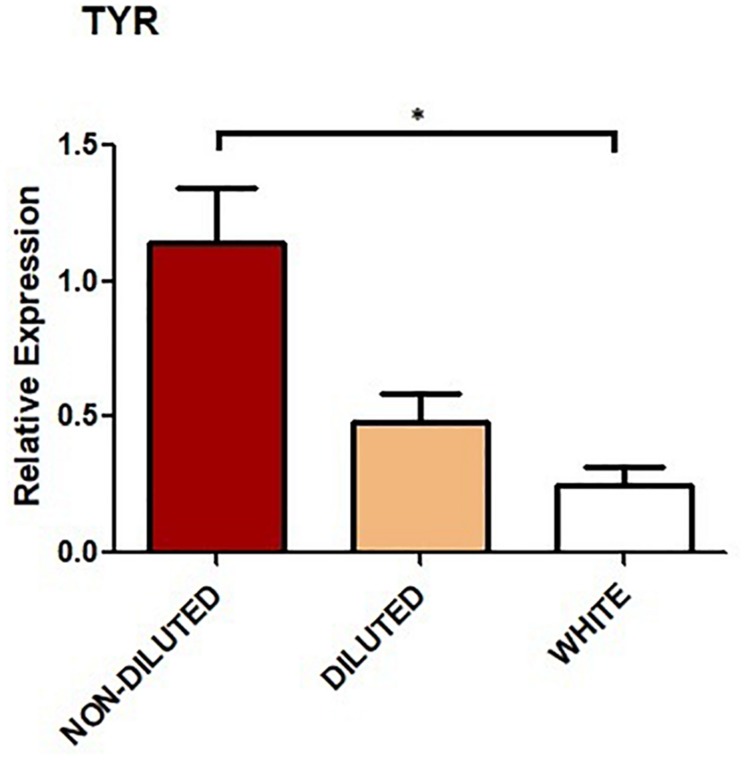
Relative expression of TYR in the skin of llamas. Bar graphs show mean values. Error bars represent standard error (SE). Three biological replicates were analyzed for each color group. Asterisk indicates statistically significant differences (p < 0.05).